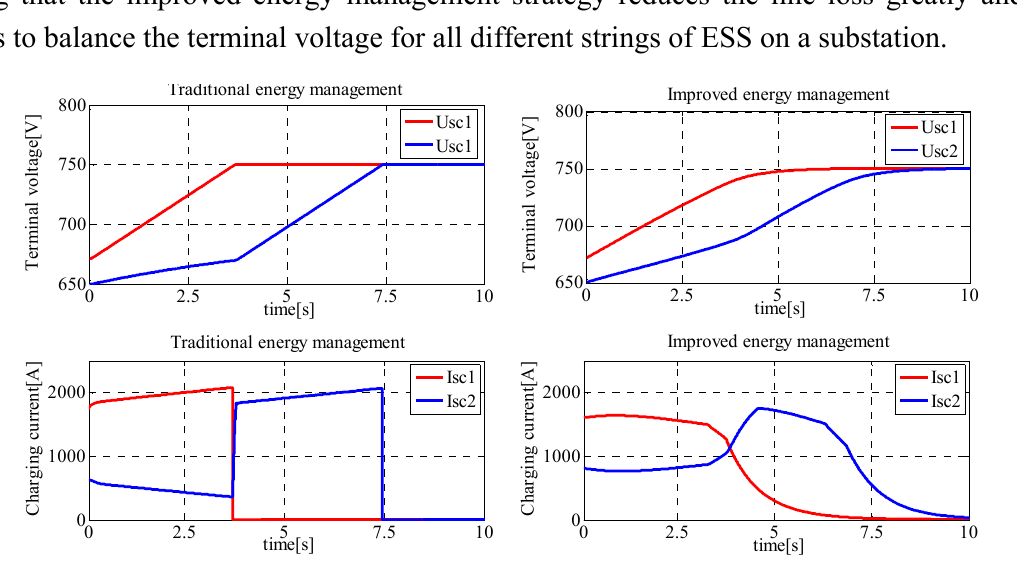
Figure 12. Terminal voltage and charging current of